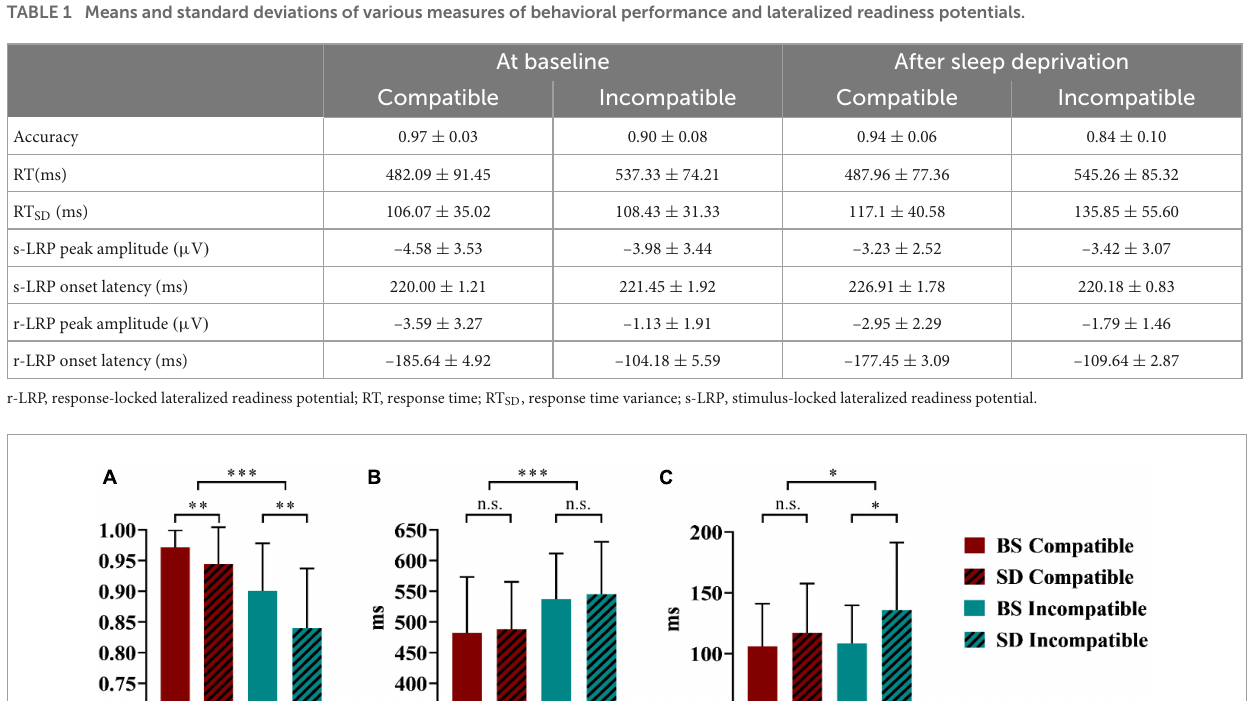
TABLE 1 Means and standard deviations of various measures of behavioral performance and lateralized readiness potentials.